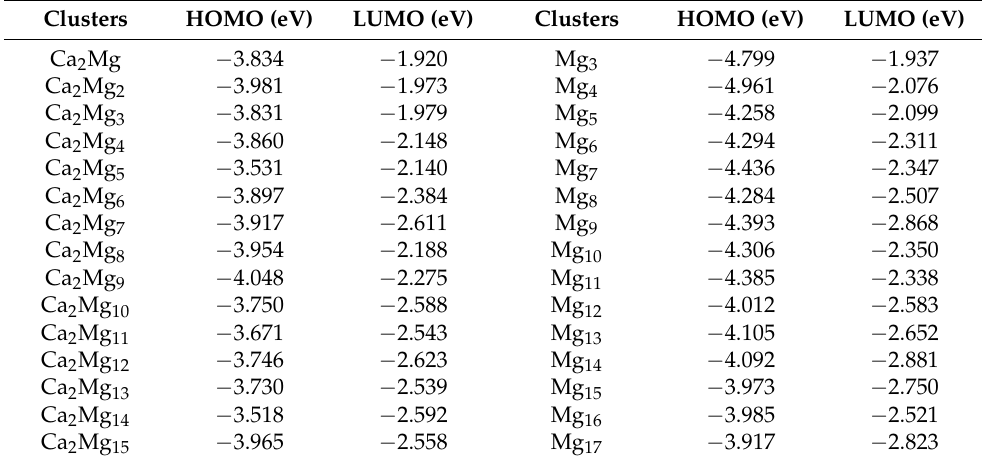
Table 2. The HOMO and LUMO energy of Ca 2 Mg n and Mg n +2 ( n = 1–15).